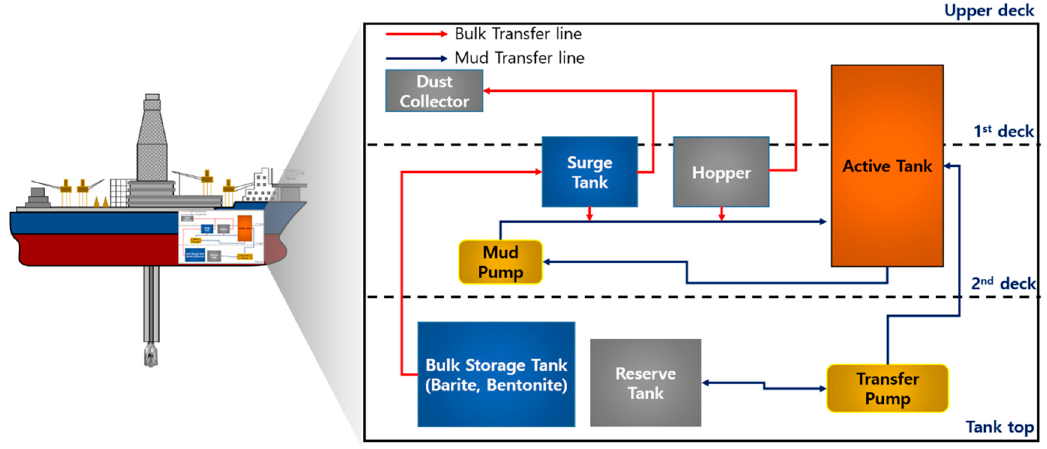
Figure 2. Schematic of BTS inside hold of drillship.